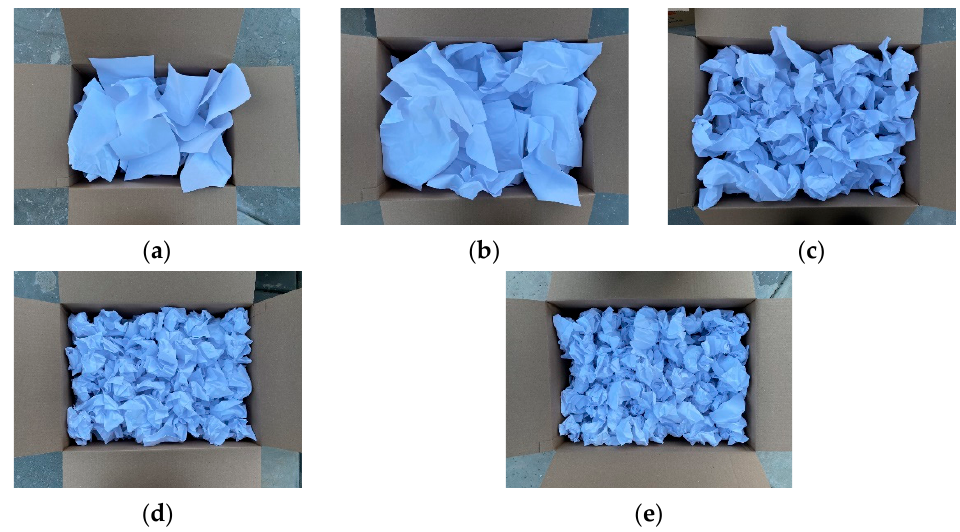
Figure 4. Visual of the five different stages of paper quantity; (a) Stage I, (b) Stage II, (c) Stage III, (d) Stage IV, and (e) Stage V.